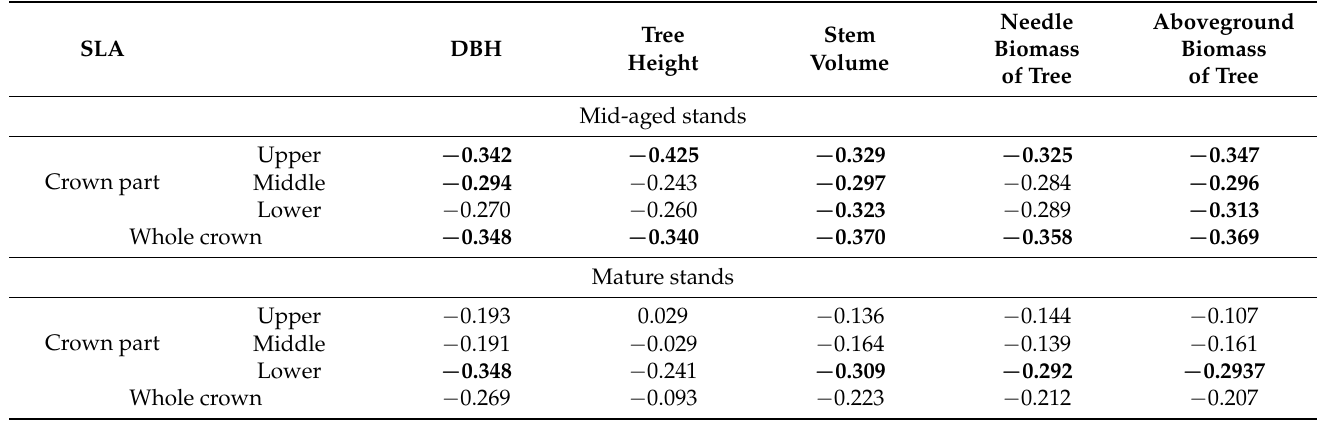
Table 5. Pearson’s correlation coefficients for the SLA and selected stand parameters of the Scots pine sample trees.